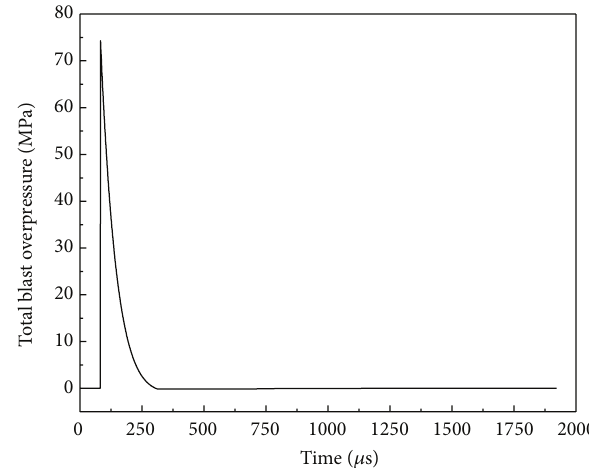
Figure 3: Overpressure evolution of surface blast with 1kg TNT charge and SoD = 350